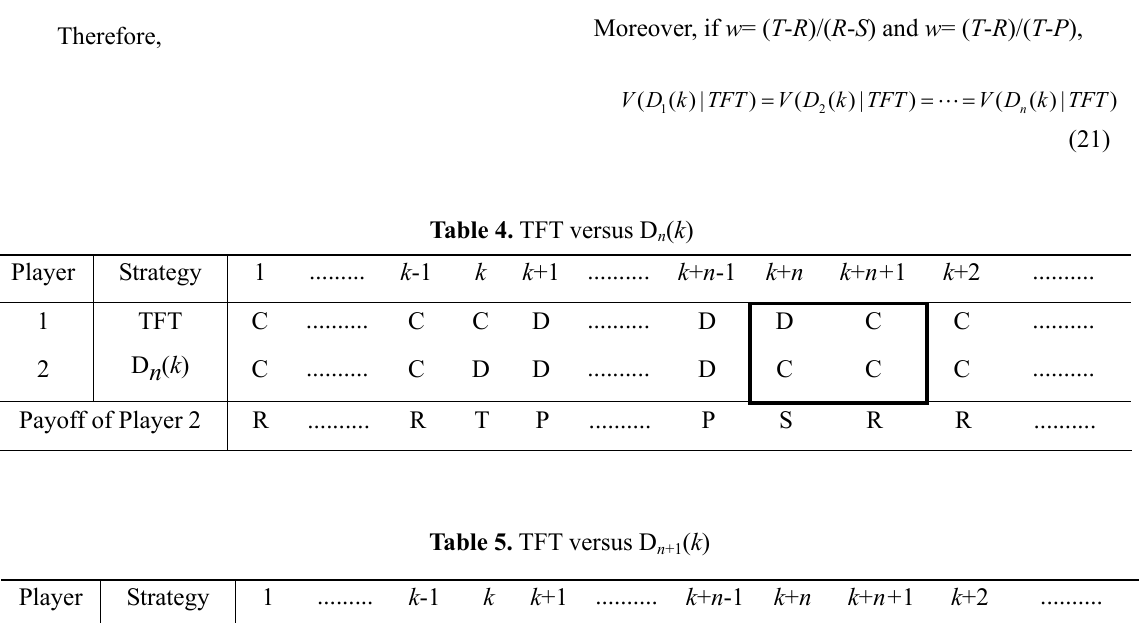
Table 5. TFT versus D